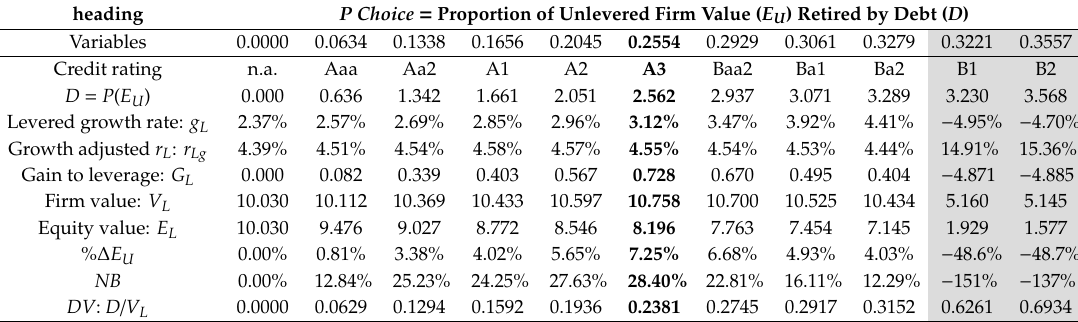
Table to Accompany Appendix C: Pass-through Outputs when Growth is